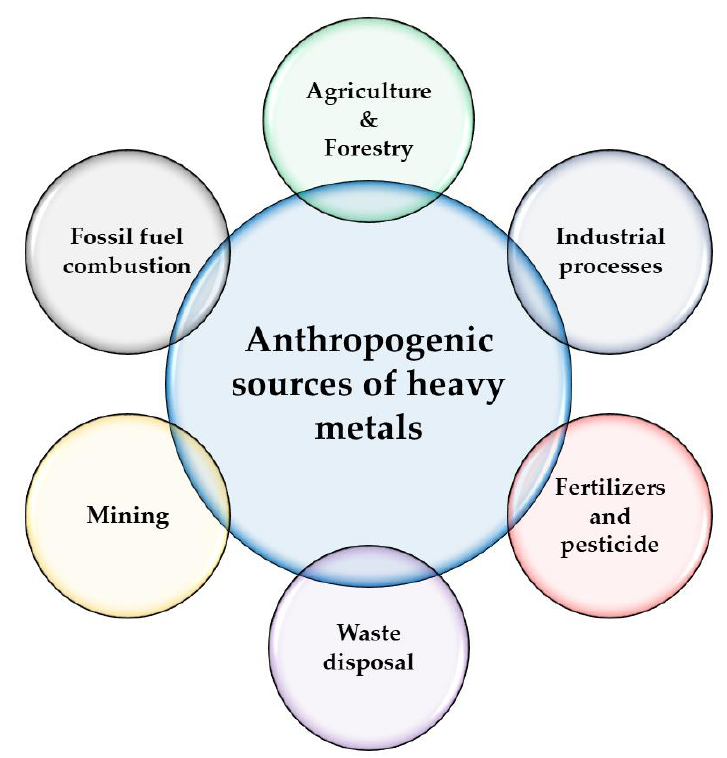
Figure 1. Anthropogenic sources of heavy metal pollution.